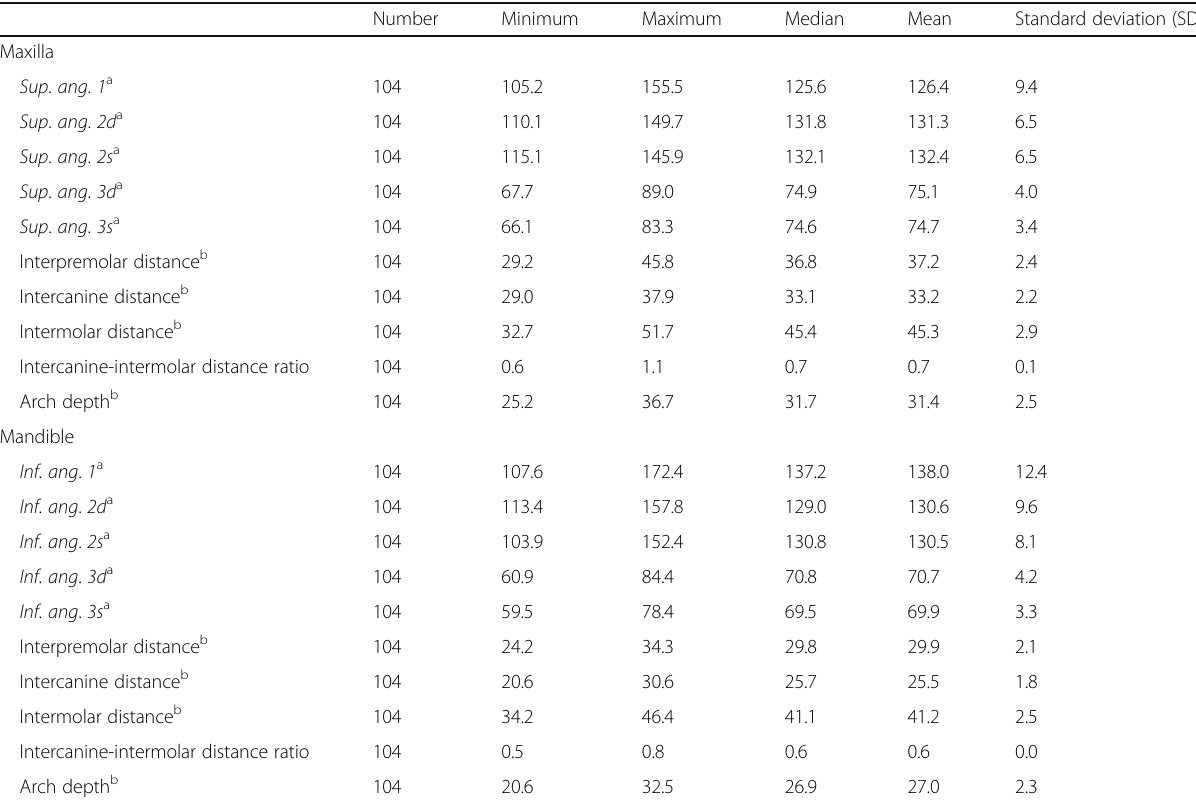
Table 1 Descriptive